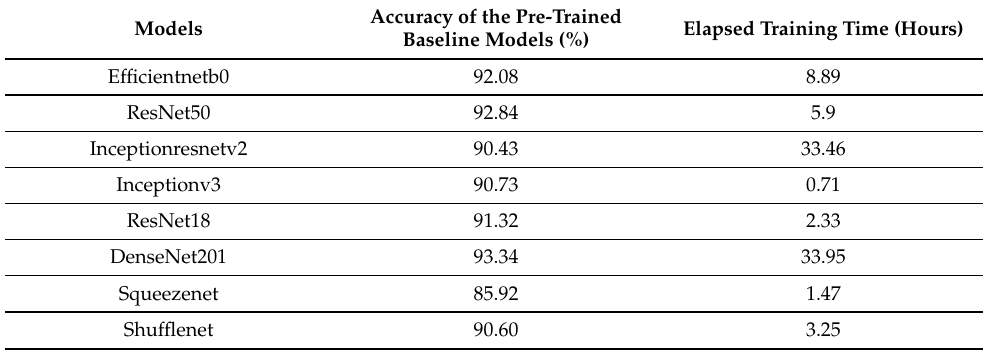
Table 7. Performance of the eight pre-trained models.